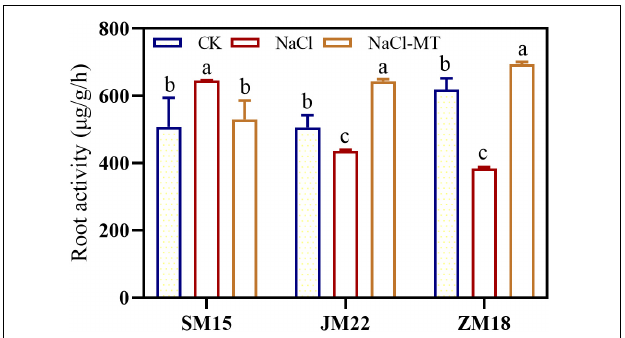
FIGURE 6 | Effects of MT on root activity under salt stress. For each trait, bars with the same letter are not significantly different according to Duncan’s test at a p < 0.05 threshold.